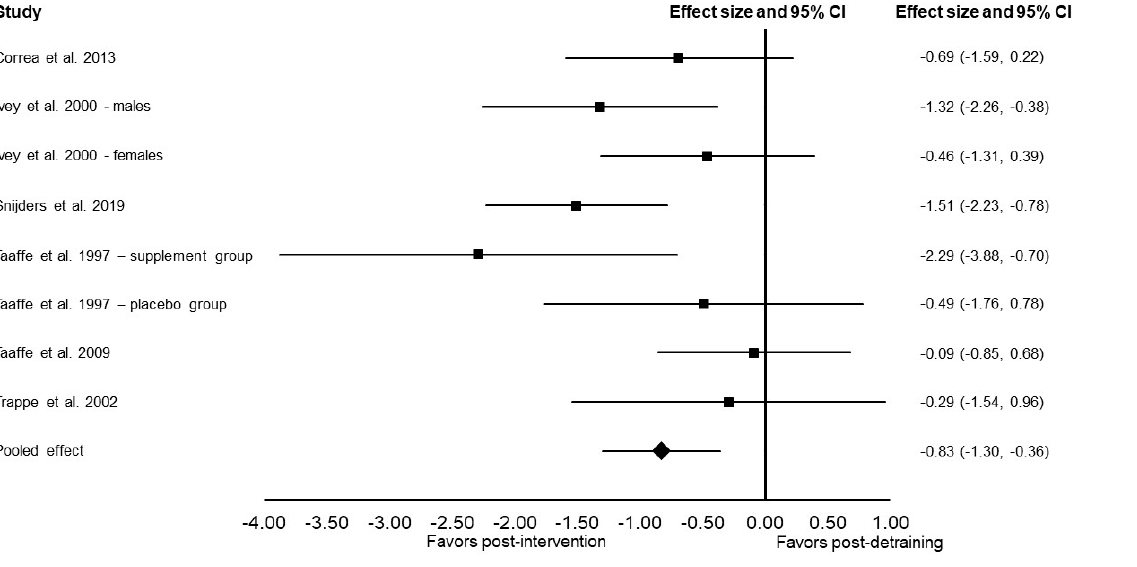
Figure 3. Forest plot presenting the results of the meta-analysis examining the effects of training cessation (detraining) on muscle size in older adults. Data are reported as Cohen’s d (effect size) and 95% confidence interval (CI). The diamond at the bottom presents the overall effect. The plotted squares denote effect sizes, and the whiskers denote their 95% CIs. The statistical weight of the studies ranged from 6.7% to 16.1% [11–16].